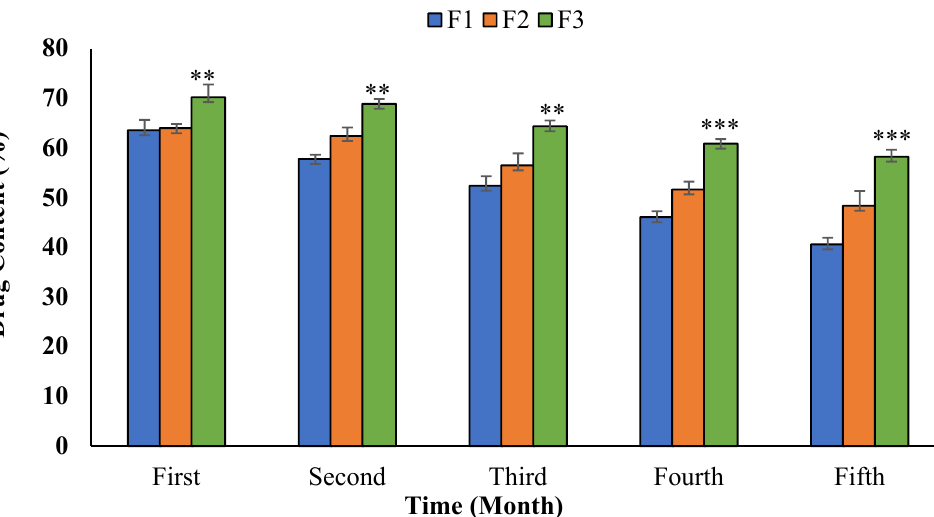
Figure 5. Drug contents of the curcumin-loaded SEDDS over the long-term storage (*** p < 0.001, and ** p < 0.05) compared to F1, F2, and F3 on day 0.